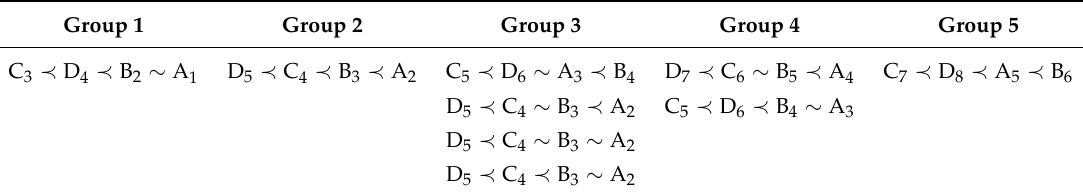
Table 8. The consensus ranking(s) of salmon samples (A, B, C, D) in each group. Group